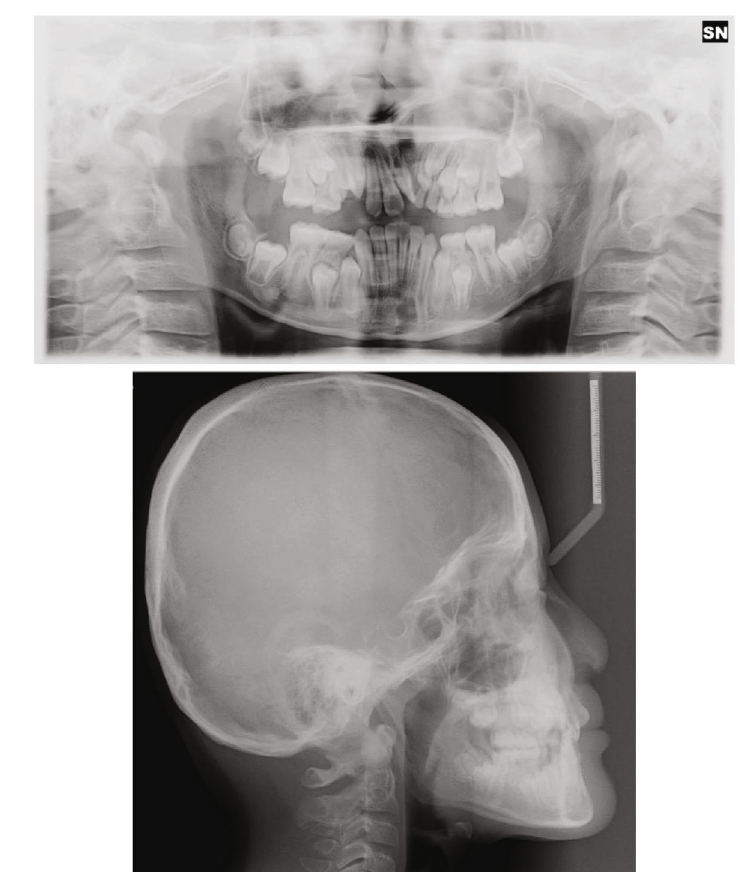
Figure 4: Initial panoramic radiograph and lateral cephalogram of the